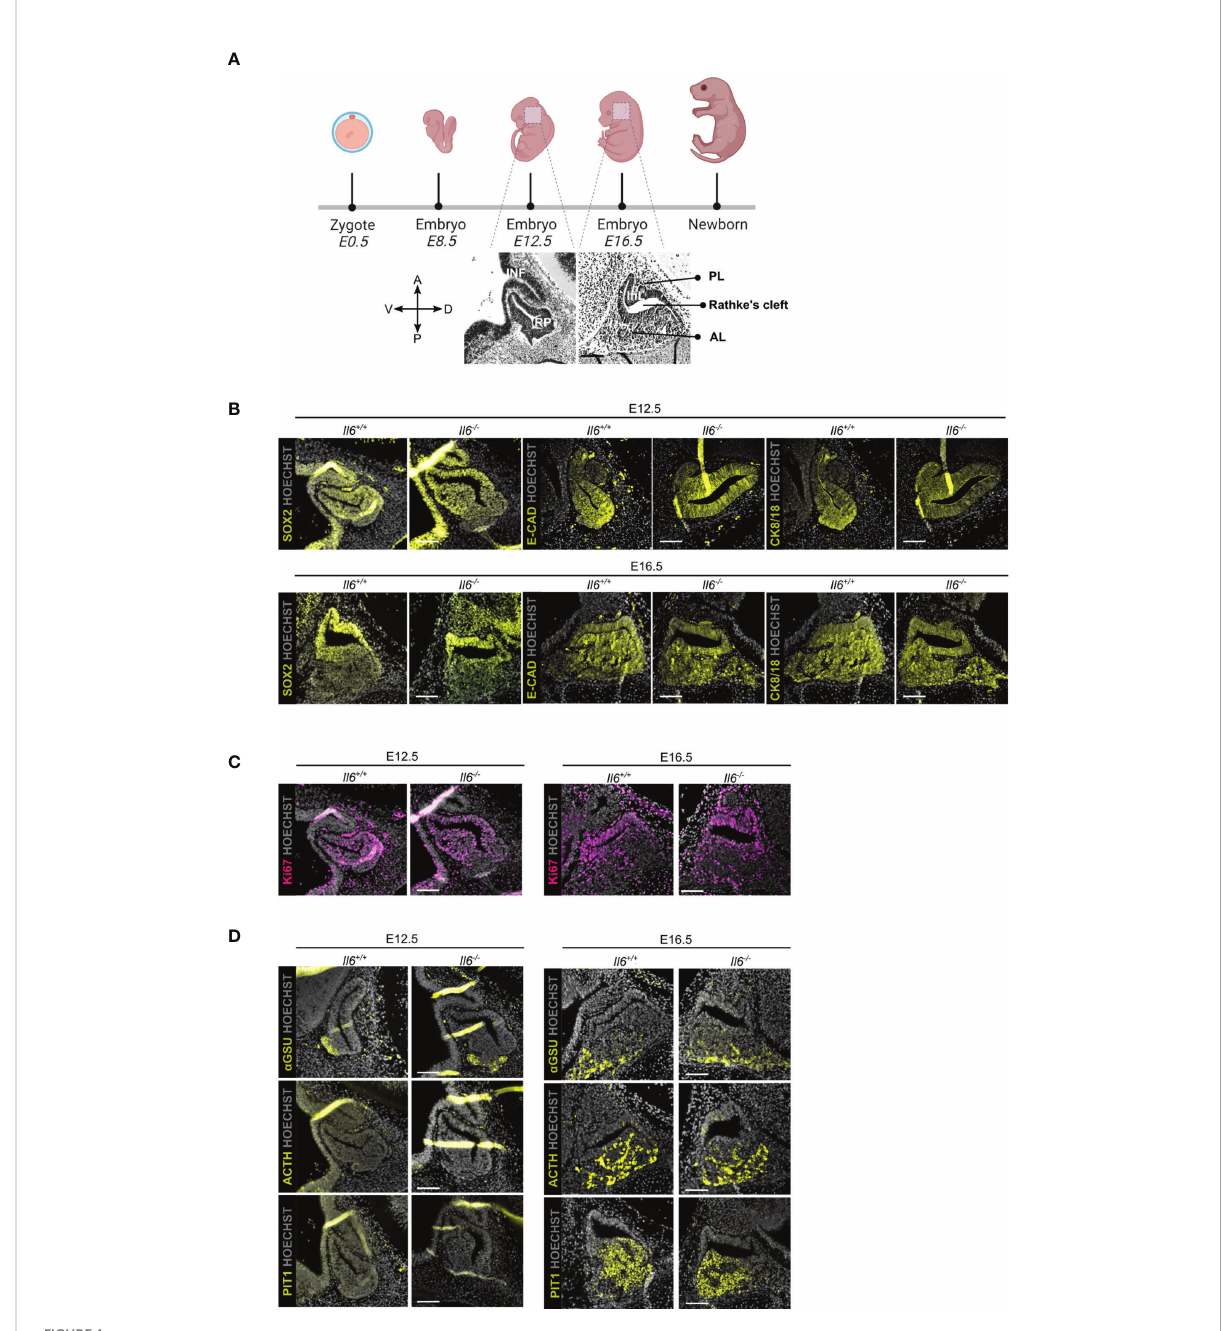
FIGURE 1 Pituitary embryonic phenotype is not affected by absence of IL-6. Overview of mouse embryonic development; embryonic day (E) 12.5 and 16.5 are highlighted and morphology of developing pituitary is shown (created with BioRender.com) (A) . Immuno fl uorescence analysis of Il6 +/+ and Il6 -/- pituitary at E12.5 and E16.5 for SOX2, E-CAD and CK8/18 (all yellow) (B) , for Ki67 (magenta) (C) and for a GSU, ACTH and PIT1 (all yellow) (D) . Hoechst33342 was used as nuclear stain (grey). Scale bar, 100 m m. A, anterior; D, dorsal; P, posterior; V, ventral; INF, infundibulum; RP, Rathke ’ s pouch; InL, intermediate lobe; PL, posterior lobe; AL, anterior